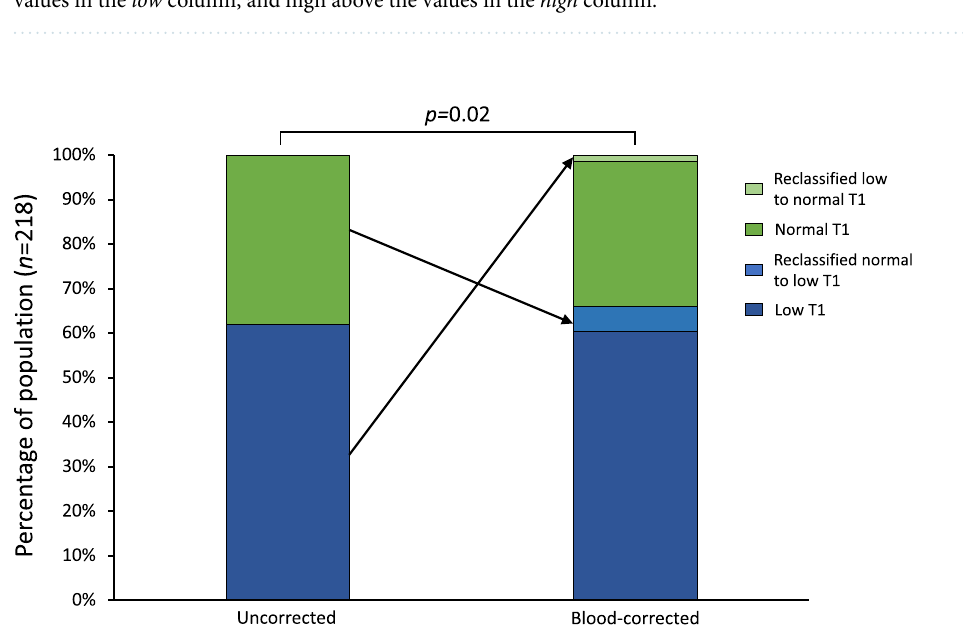
Figure 1. The classification of patients before and following blood-correction. The figure shows the percentage of patients with low T1 (dark blue) and normal T1 (darkt green) before and following blood-correction